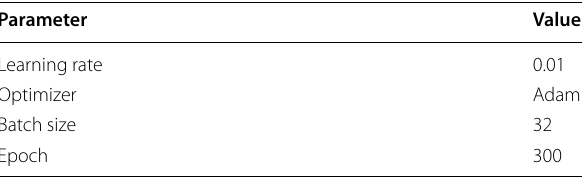
Table 3 Parameters setting of the proposed classification network Parameter